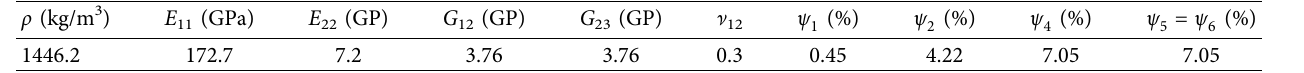
Table 1: Mechanical properties of carbon/epoxy composite material [13].